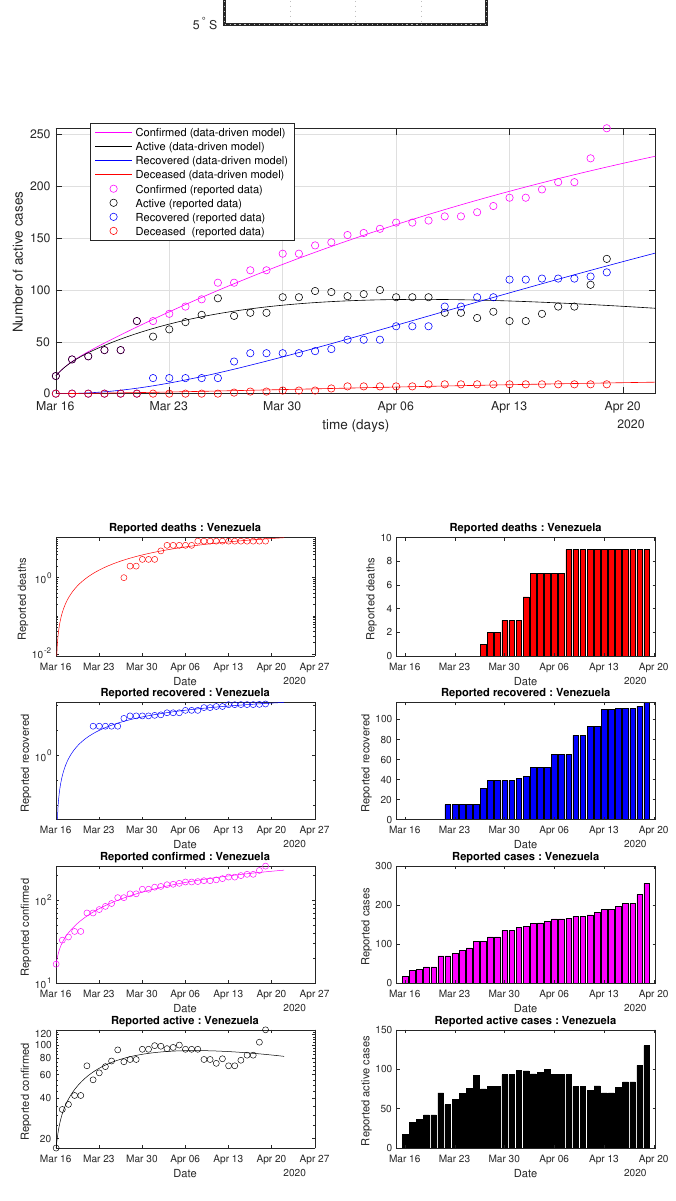
Figure 29. Venezuela: data of active, recovered, deceased (in circle or bar) vs. model of active, recovered, deceased over time. Tracking the number of active cases. Predictive analytics for the next couple